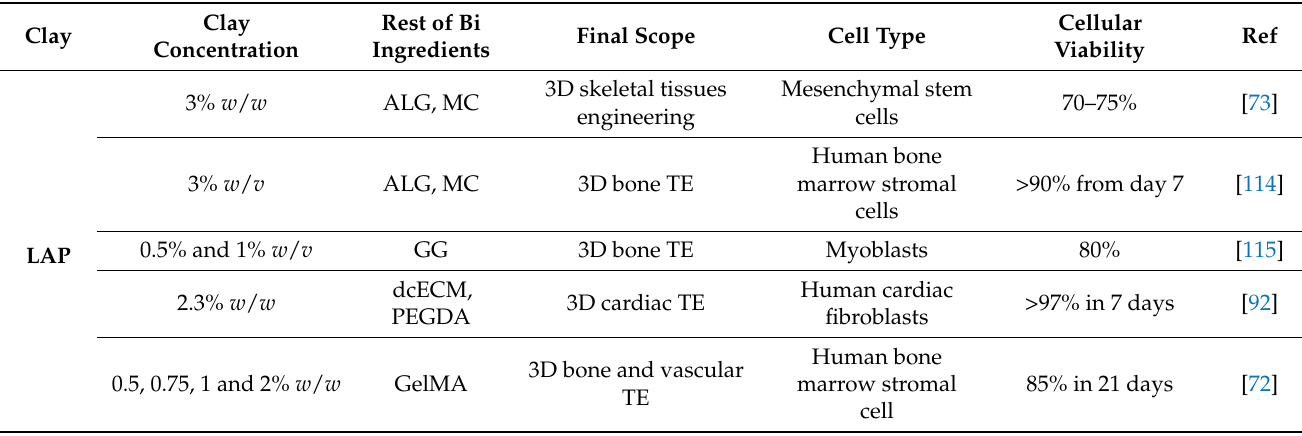
Table 4. Bioinks, including clay minerals in their formula: clay type and concentration, final scope, and cellular viability. Clay